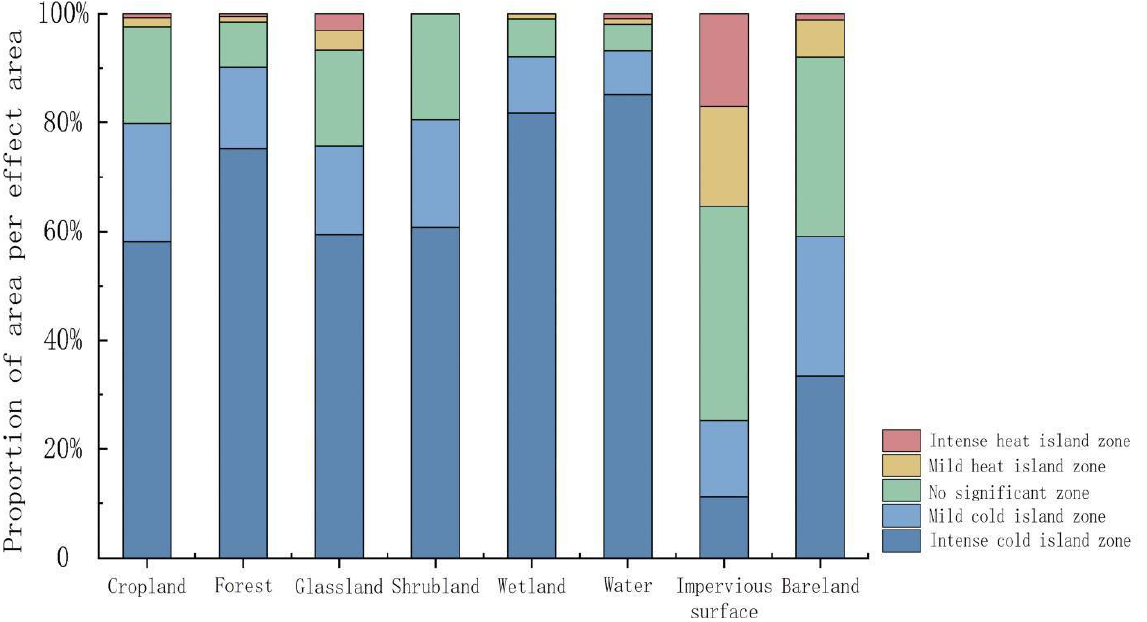
Figure 4. Scale diagram of UHII for different land cover types in